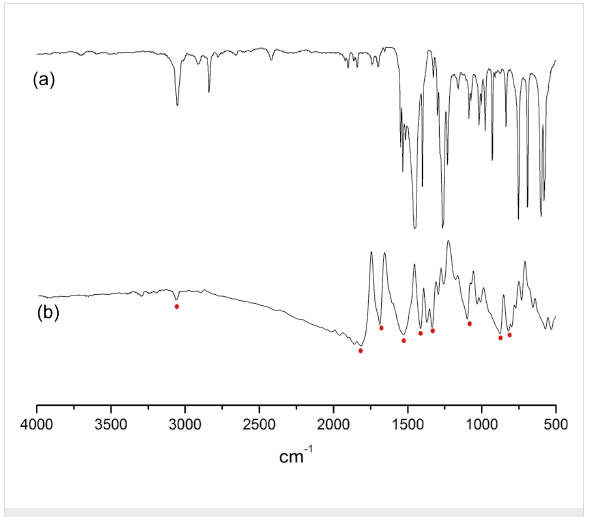
Figure 1: IR spectra of (a) nitrobenzene and (b) ZVI NPs modified by 4-nitrobenzenediazonium